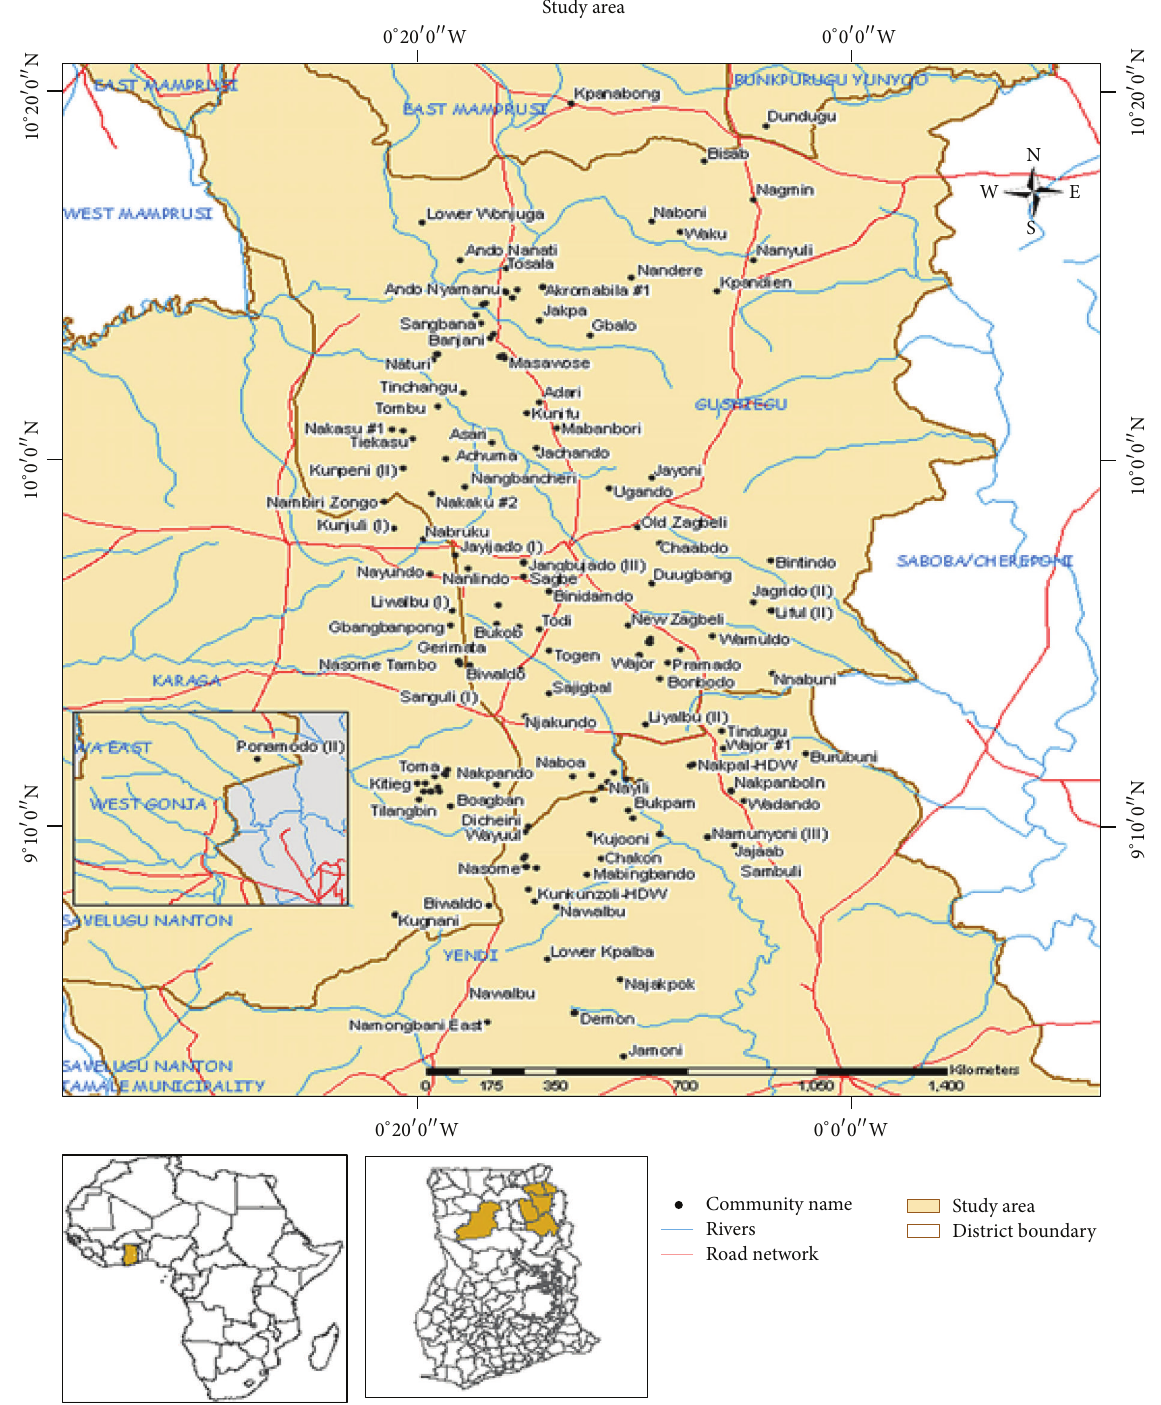
Figure 1: A map of the study area showing the major communities and